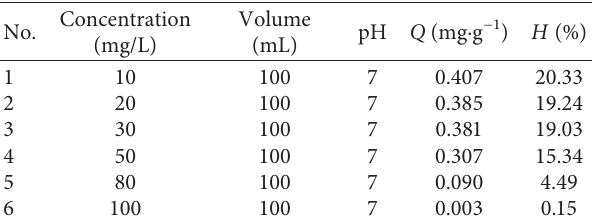
Table 8: Effect of initial concentration on the Cr (VI) ion ad- sorption process.